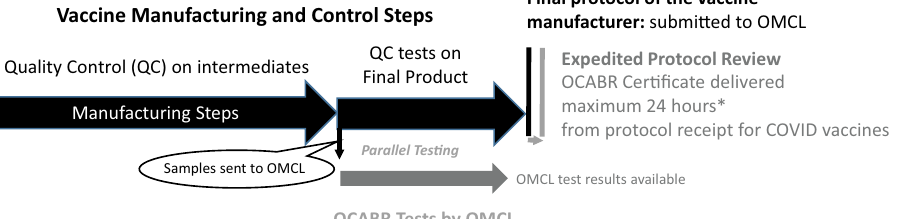
Fig. 1 Principle of parallel testing during OCABR. Black horizontal arrows denote elements in the manufacturer ’ s production and control process; grey horizontal arrows represent elements of the OCABR process at the OMCL. Black vertical line is release of the manufacturer ’ s protocol with QC results to the OMCL, grey vertical line is the release of the OCABR certi fi cate for compliant batches *Represents the timing in the fi rst months of the COVID-19 campaigns, subsequently the average range was 1 – 3 days.